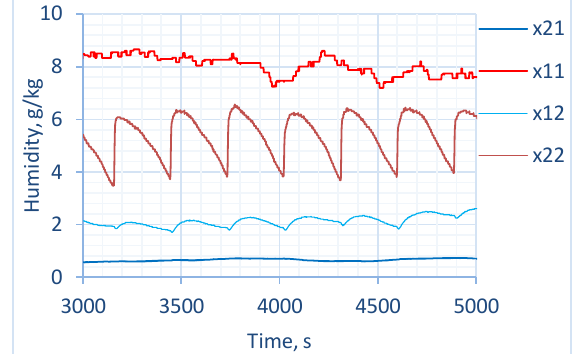
Fig. 5. Fresh 𝑥 21 , supply 𝑥 22 , exhaust 𝑥 11 and waste 𝑥 12 air humidity